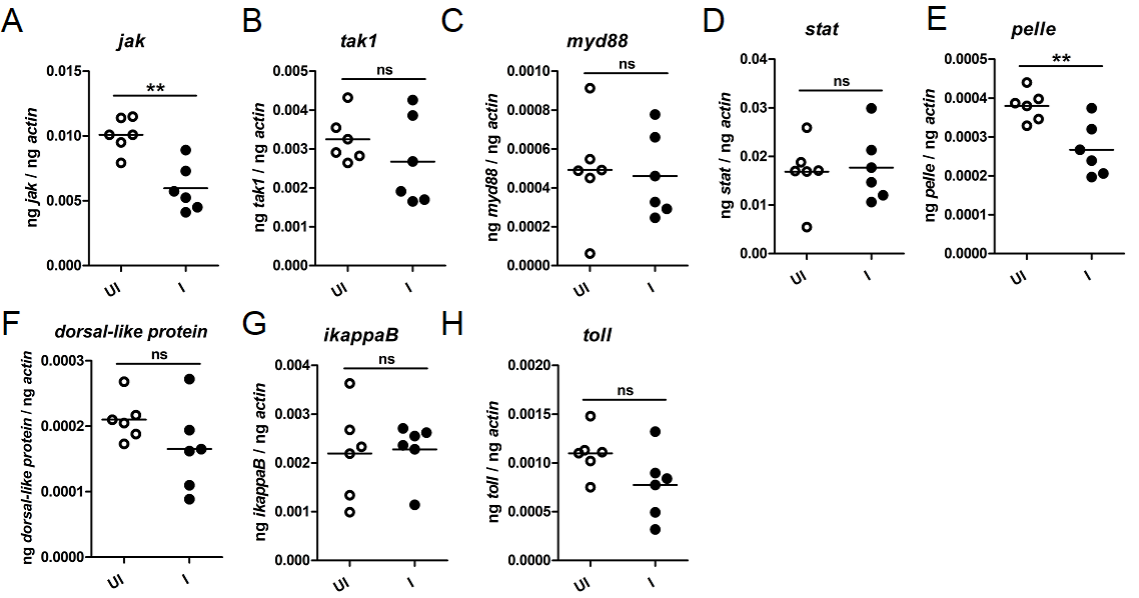
Figure 5. Expression of tick jak1 and pelle are downregulated during transmission of A. phagocytophilum from ticks to the murine host. QRT-PCR results showing levels of tick jak ( A ); tak1 ( B ); myd88 ( C ); stat ( D ); pelle ( E ); dorsal-like protein ( F ); ikappaB ( G ); and toll ( H ) transcripts in uninfected (open circles) or A. phagocytophilum -infected (closed circles) nymphs fed on naïve mice. Levels of tick immune gene transcripts were normalized to tick-beta actin levels. Statistical analysis was performed using Student’s t -test comparing uninfected (UI) and A. phagocytophilum infected (I) ticks. Each circle represents data from one tick sample. Statistically significant ( p < 0.01) comparisons are marked with an asterisk. ns—not significant.